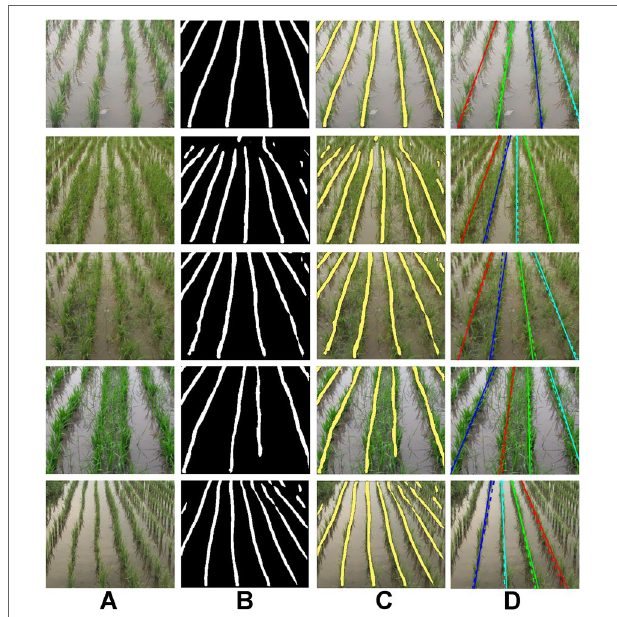
FIGURE 5 | Qualitative results of learning semantic lines using the proposed extended skip network on the paddy line dataset. (A) Test images, (B) corresponding outputs of the proposed network, (C) output superimposed on test image, and (D) extracted dominant paddy lines along with the ground truth lines (dotted). (Best viewed in color).